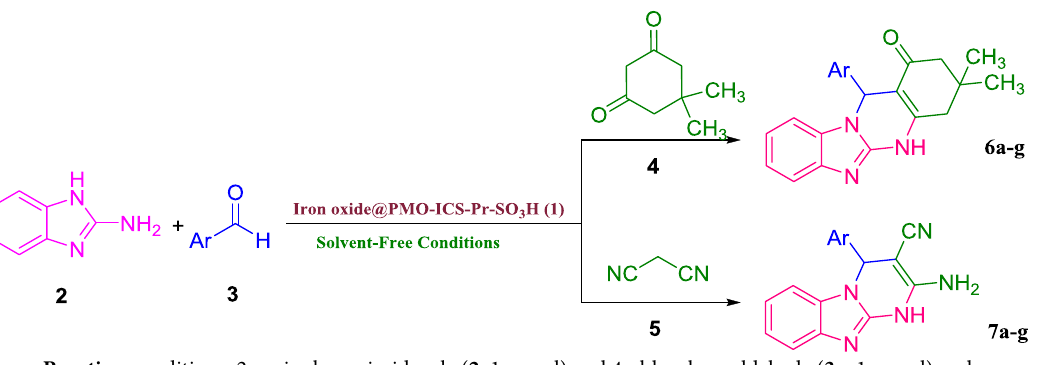
Table 2. Synthesis of the imidazopyrimidine derivatives 6a–g and 7a–g in the presence of the Iron oxide@ PMO-ICS-PrSO 3 H nanocatalyt ( 1